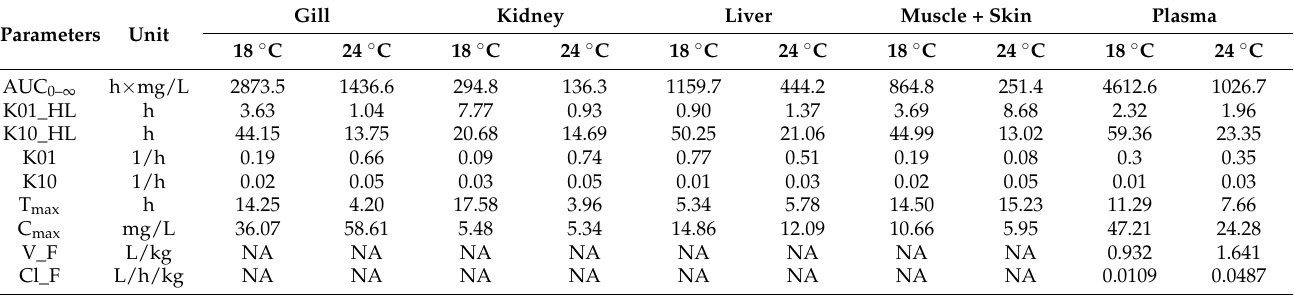
Table 3. Pharmacokinetic parameters of sulfadiazine in gill, kidney, liver, muscle + skin and plasma of grass carp ( Ctenopharyngodon idella ) after a single oral dose of 50 mg/kg at 18 and 24 ◦ C.